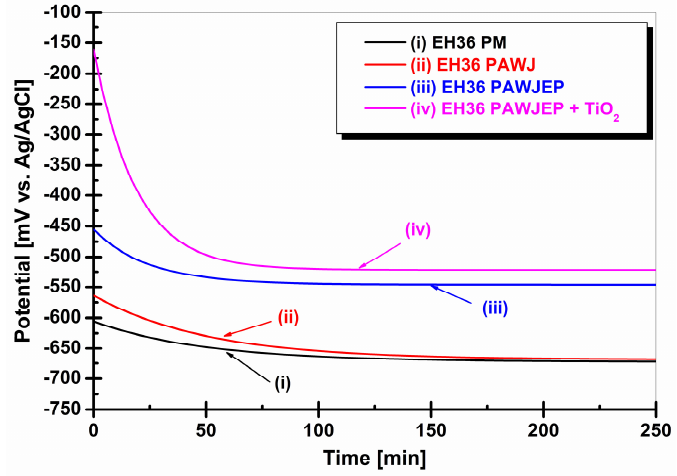
Figure 7. Evolution of open-circuit potential versus immersion time in seawater for: (i) EH36PM without protective coating used like parent material, (ii) EH36PAWJ without protective coating, (iii) EH36PAWJEP coated with polymeric primer and (iv) EH36PAWJEP + TiO 2 coated with nanocomposite polymeric primer with dispersed TiO 2 nanoparticles.